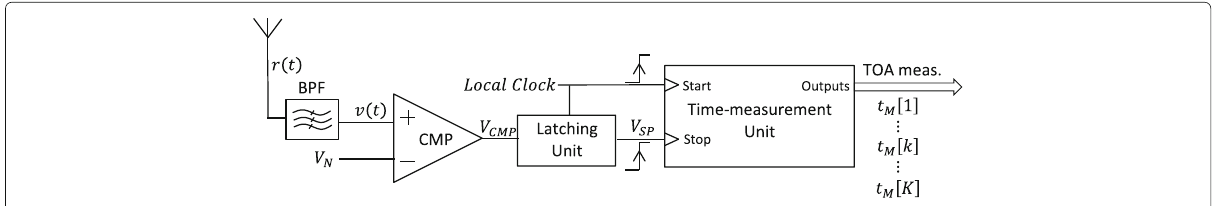
Fig. 1 Block diagram of the proposed